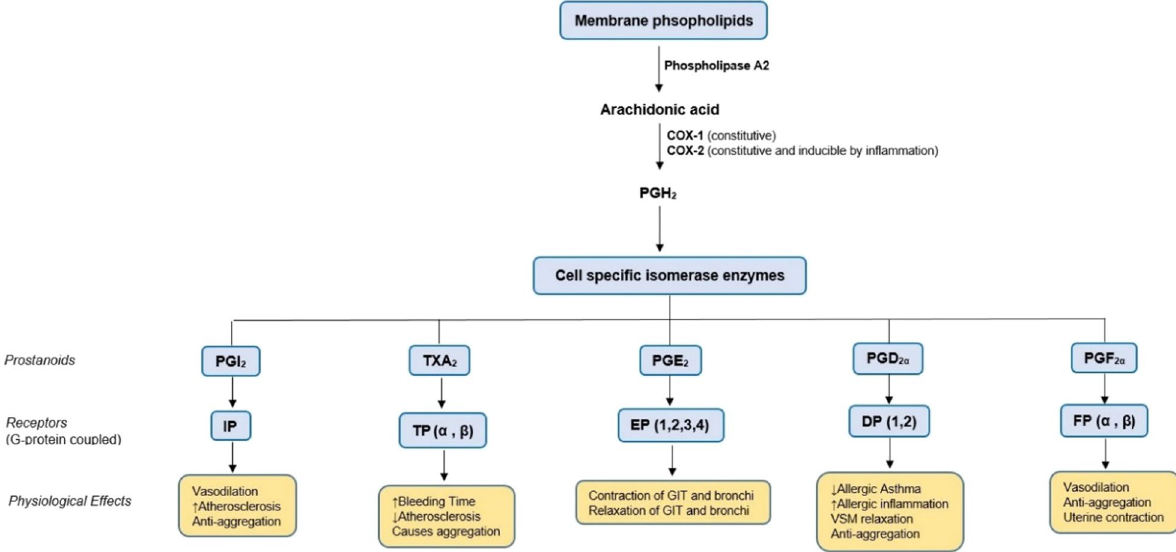
Fig. 1 Synthesis and Functions of Prostanoids. Normally, the constitutive isoforms of COX enzymes are produced by the action of phospholipase A 2 on membrane phospholipids; but in inflammatory diseases, phospholipase A 2 is triggered to produce inducible COX-2. Prostaglandin H 2 is the precursor of the five main types of prostanoids which generates them upon the catalysis of specific isomerase (synthase) enzymes for each type [6, 8]. GIT indicates gastrointestinal tract. VSM, vascular smooth